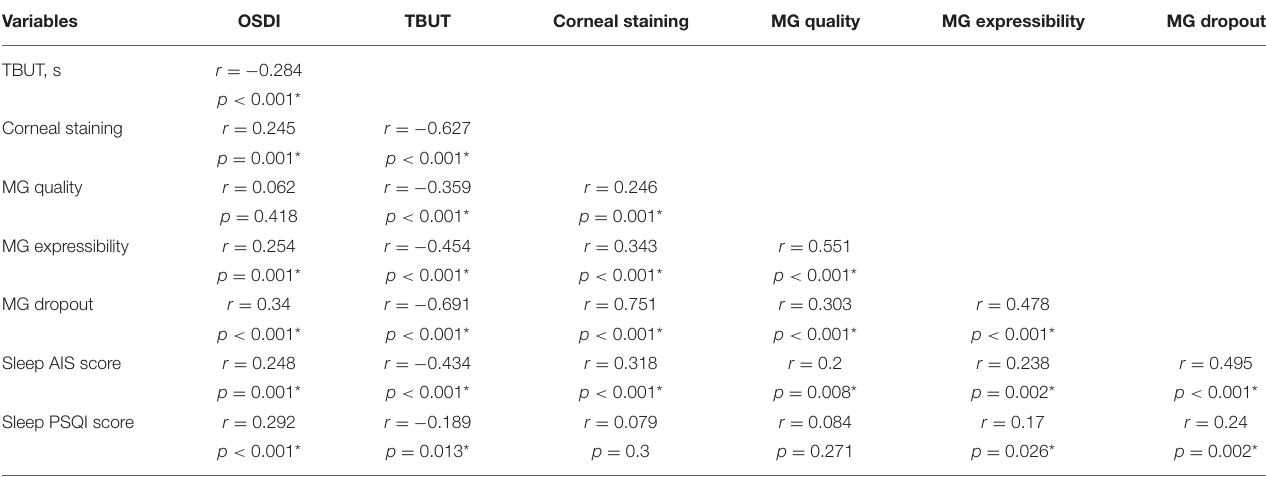
TABLE 2 | Correlation between sleep quality and dry eye parameters. Variables OSDI TBUT Corneal staining MG quality MG expressibility MG dropout